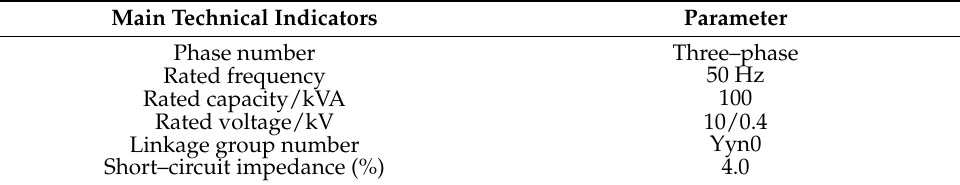
Table 1. Parameters of transformer.